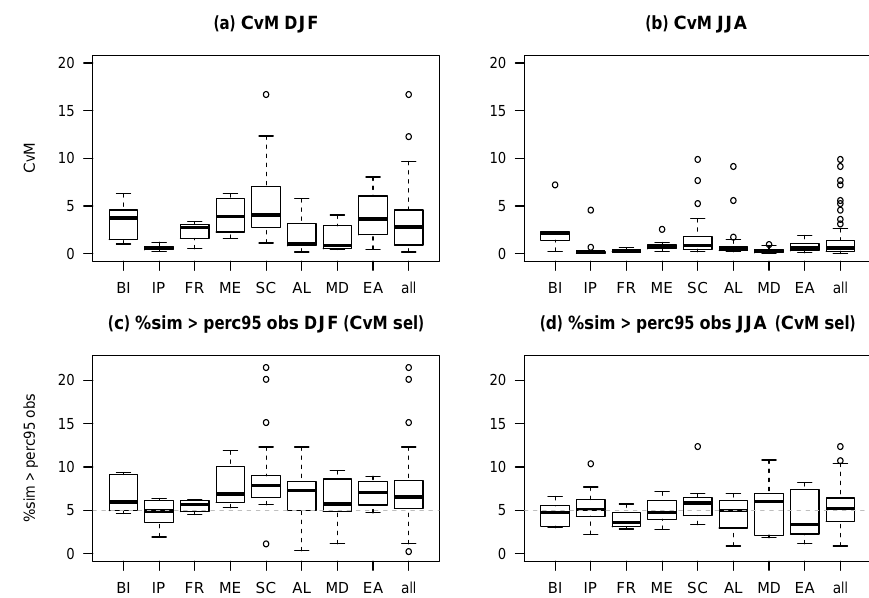
Figure 9. Steps 1 and 2: combined model. Boxplots of (a, b) CvM score and (c, d) percentage of simulated wet days exceeding the ob- served 95th percentile (%sim > perc95 obs ) for the cross-validated CvM-selected model. Regions: British Isles (BI), Iberian Peninsula (IP), France (FR), Mid-Europe (ME), Scandinavia (SC), Alps (AL), Mediterranean (MD), and eastern Europe (EA). Note the different scales of the y axes than in Fig. 5. Outliers out of range in (a) ME and all: 22.19; SC and all: 27.12 and